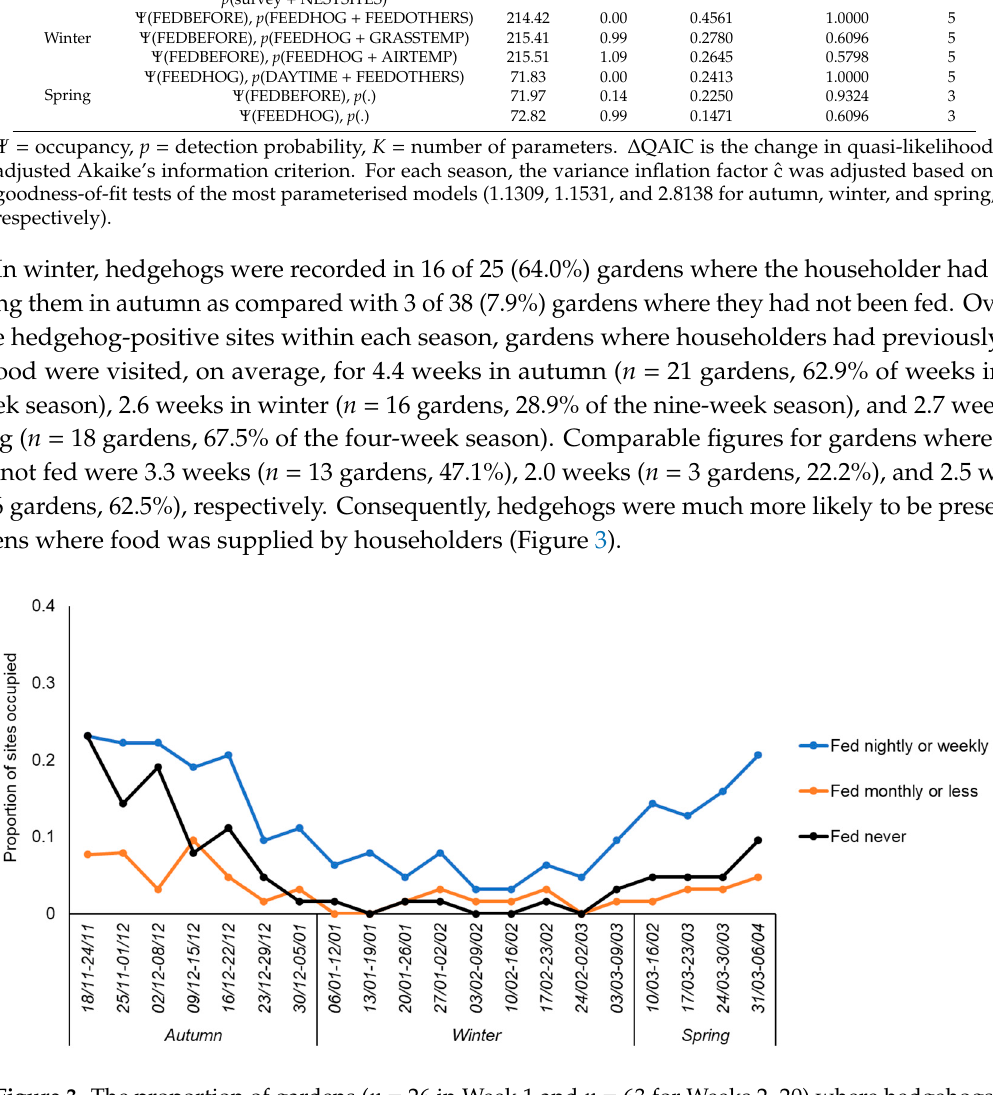
Figure 3. The proportion of gardens ( n = 26 in Week 1 and n = 63 for Weeks 2–20) where hedgehogs were detected in relation to the frequency with which householders provided food at the outset of the study. Weekly survey dates are given in the format dd / mm , running from November 2017 to April 2018 inclusive.